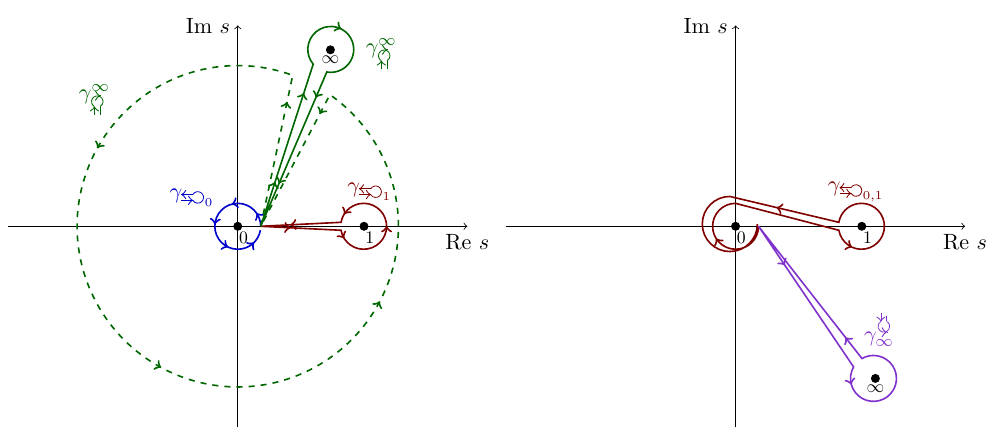
Figure 8 . Paths around 0 , 1 and ∞ . We depict two possible contours that go around infinity, starting at points in the upper or lower half-plane. These are each homotopic to paths around 0 and 1, but in different orders. The two contours around infinity are not homotopically equivalent. The right panel shows that the path ambiguity is present also for paths around s = 1